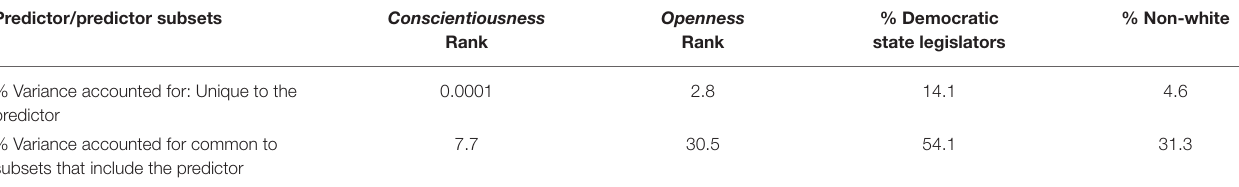
TABLE 4B | Commonality regression analysis of the percentage of state population who always wear a face covering when in public. Predictor/predictor subsets